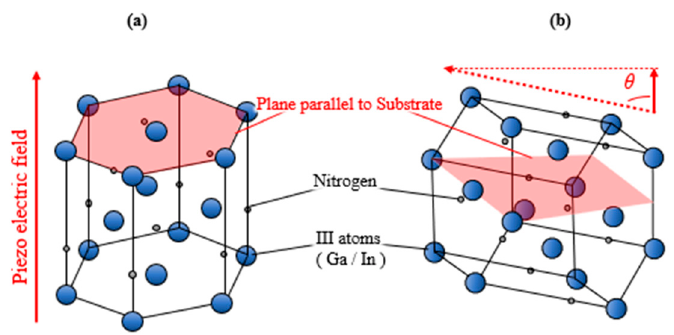
Figure 11. ( a ) The {0001}-orientated, or so-called c-orientated, lattice is shown. ( b ) The {20–21}-orientated lattice is shown. The {20–21} lattice is obtained by rotating the {0001} lattice by 75 degrees towards the m direction. The rotation of the crystal reduces the piezoelectric field normal to the substrate, thereby suppressing the QW degradation for high indium incorporation.